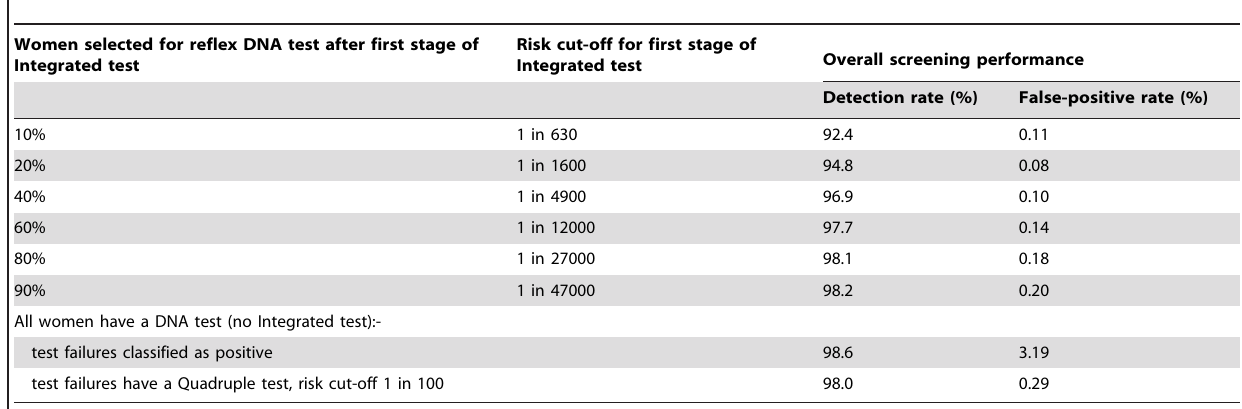
Table 1. Screening performance of reflex DNA tests with the Integrated test according to percentage of women having reflex DNA test (Integrated test risk cut-off 1 in